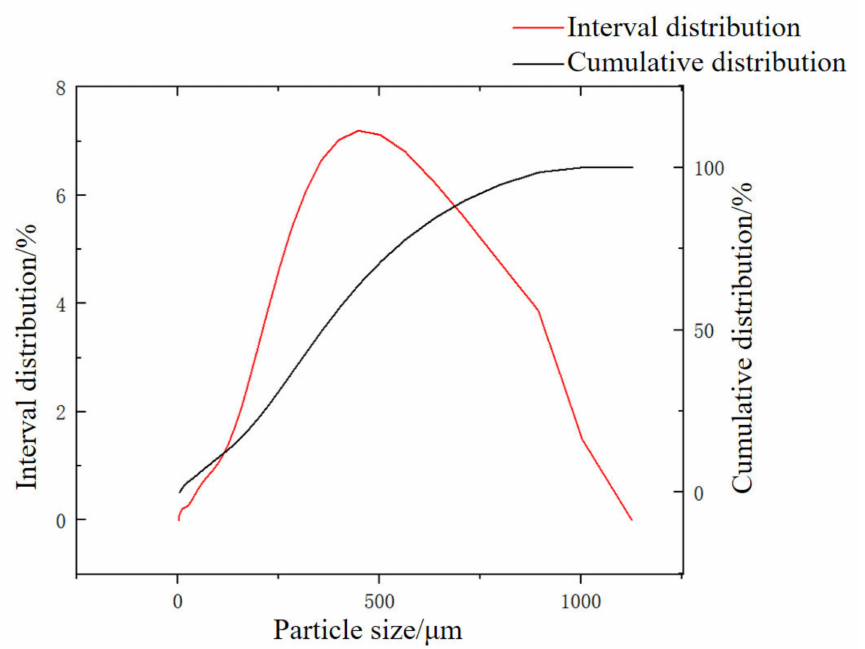
Figure 3. Particle size distribution curve of